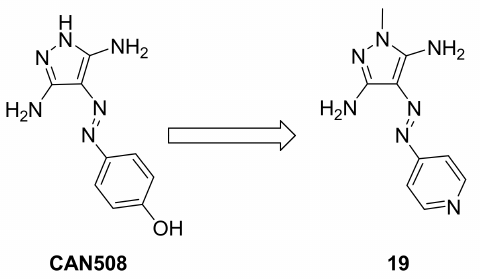
Figure 27. Structure of CAN508 and the development of compound 19 from